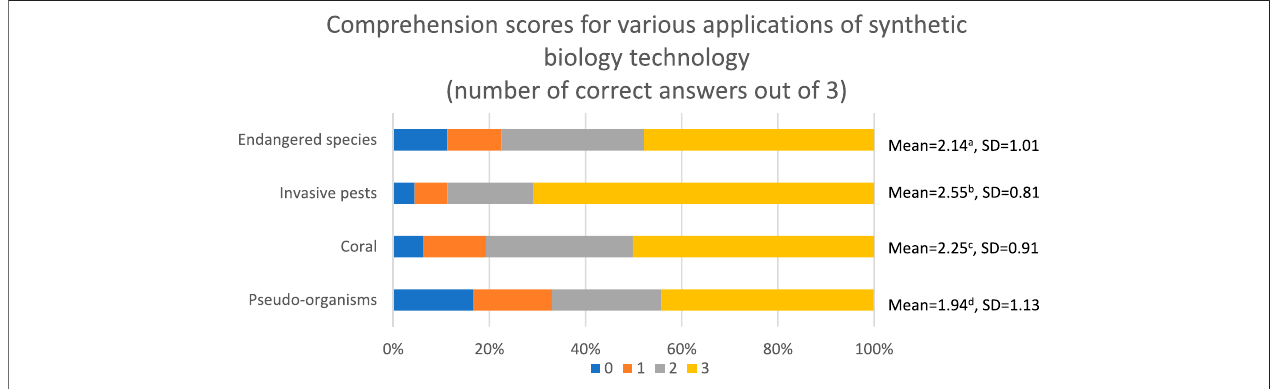
FIGURE1 | Comprehension scoresfor the various applicationsofsynthetic biology technology (based on the information supplied in the technology storyboards). Notes: Different superscripts (a, b, c, and d) denote statistically signi fi cant differences between the means.